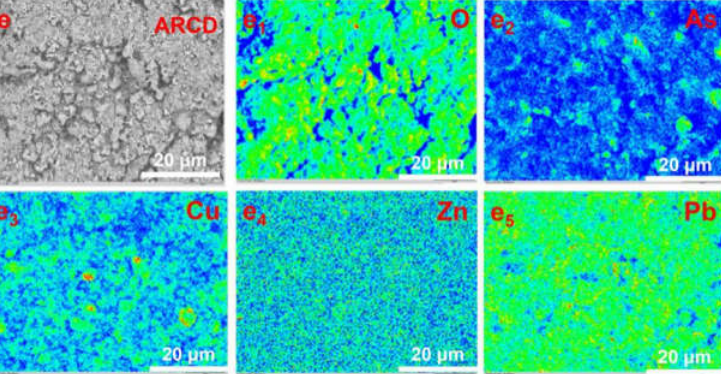
Figure 1. ( a ) XRD pattern of ARCD, ( b ) XPS spectra of ARCD, full spectrum, ( c ) As 3d, ( d ) Cu 2p3/2, ( e ) SEM-EDS of ARCD.